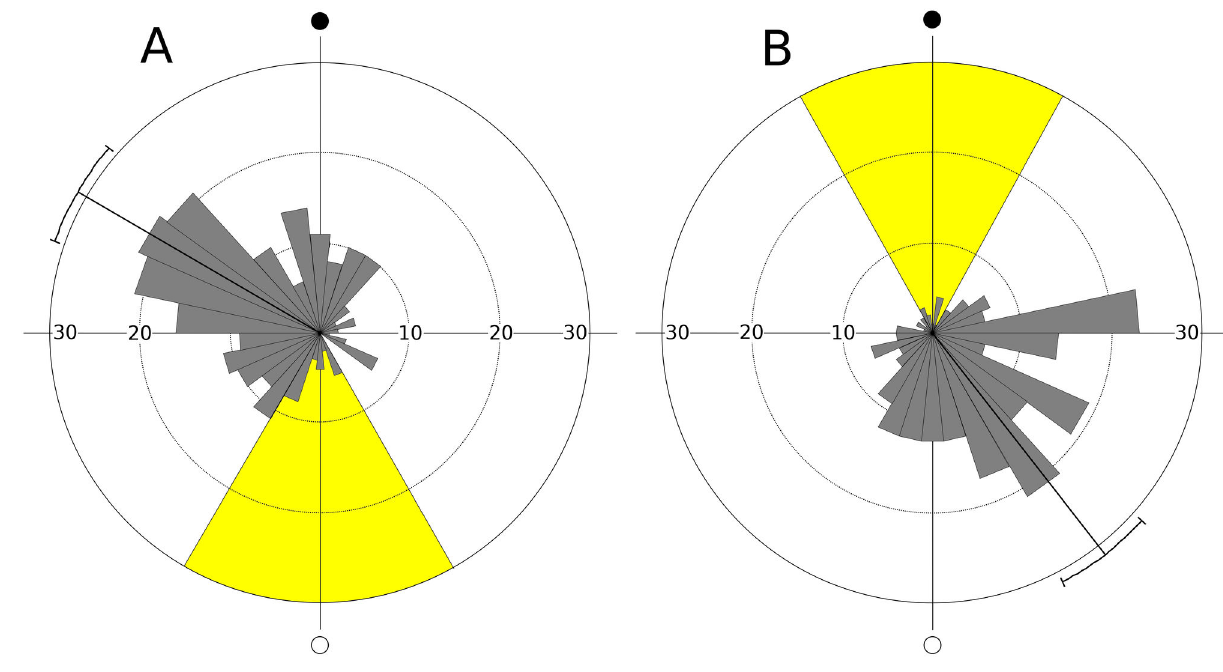
Figure 8. Circular plots for daily molt frequencies over the lunar cycle (experiment 2). Group A (N = 244): artificial cycle in phase with the natural lunar cycle; group B (N = 232): artificial cycle phase-shifted by half the lunar period. Pooled data for males and females. Mean angular direction and its 95% confidence interval are indicated. Open circle = natural full moon, filled circle = natural new moon; period of exposure to artificial moonlight marked in